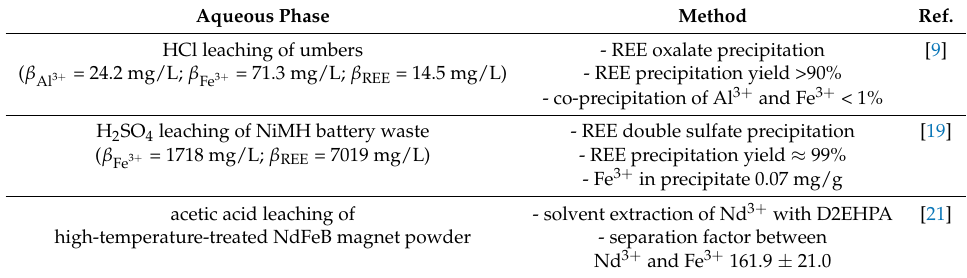
Table 1. Methods for separation of aluminum and iron from rare earth element (REE) containing